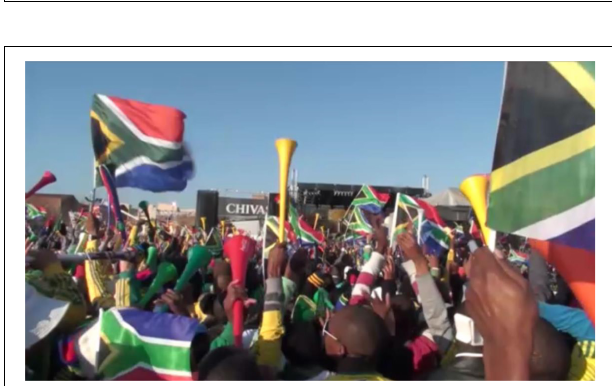
FIGURE 6 | Photo from author’s video of people in Mary Fitzgerald Square singing the South African anthem before the opening